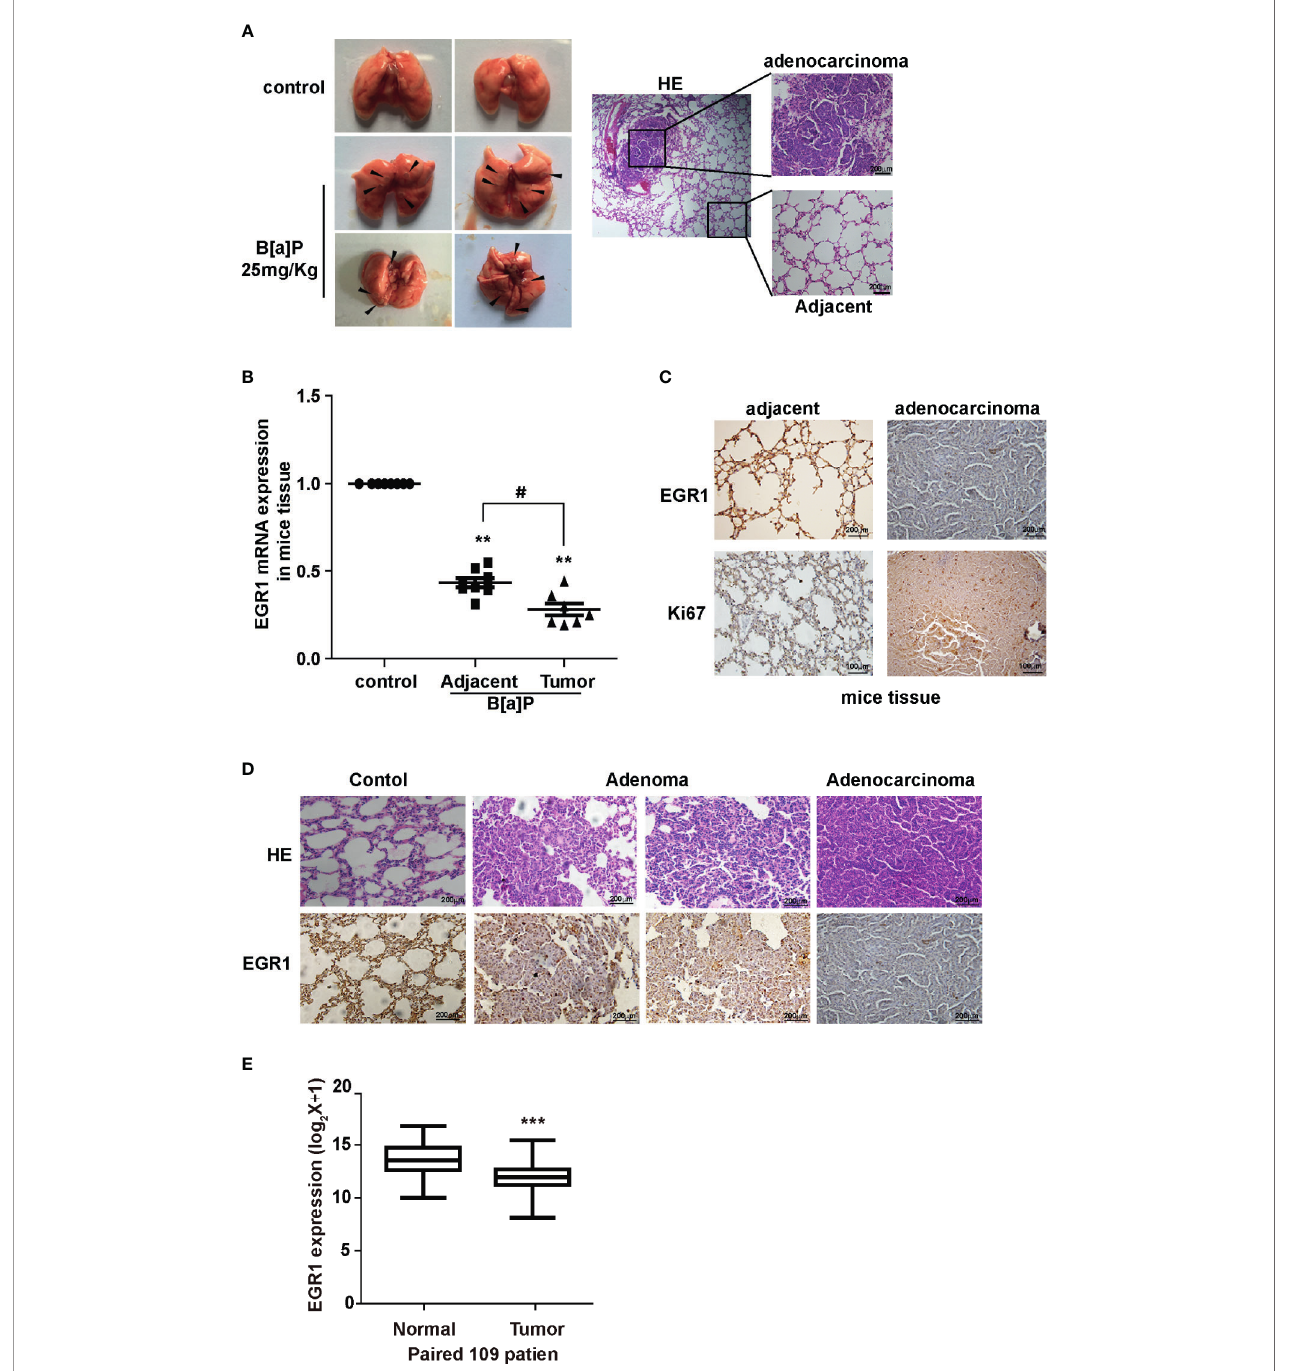
FIGURE 2 | B[a]P downregulated EGR1 expression in vivo . (A) B[a]P-induced A/J mice lung tumorigenesis. Left, representative images of primary lung tumor in mice with or without B[a]P treatment (25mg/kg); right, representative images of HE staining. (B) EGR1 mRNA expression in B[a]P-induced murine lung tumor and adjacent normal tissues, vehicle lung tissues. (C, D) Representative images of EGR1, Ki67 immuno-histochemical staining of B[a]P-treated murine lung tumor tissues and adjacent tissues, vehicle lung tissues. (E) Analysis of the TCGA database of EGR1 mRNA expression in paired lung cancer and normal tissues. The analyses were repeated three times, and the results were expressed as mean ± SD. # P < 0.05, ** P < 0.01, and *** P <